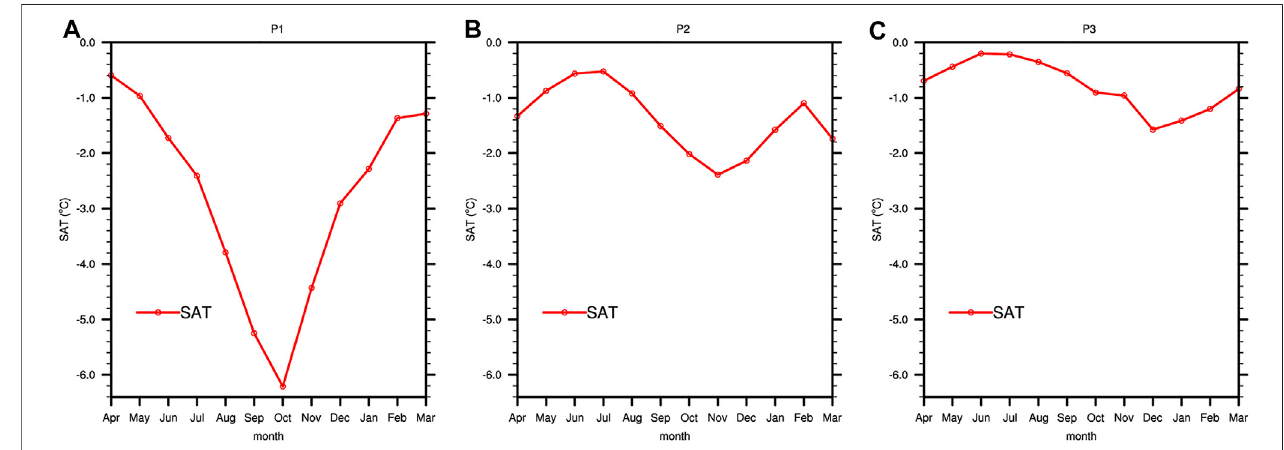
FIGURE3| Annualcycleofthesurfaceairtemperature(SAT) anomaliesovertheArcticduringPeriod-1 (A) ,Period-2 (B) ,andPeriod-3 (C) aftertheSamalasmega volcanic eruption.